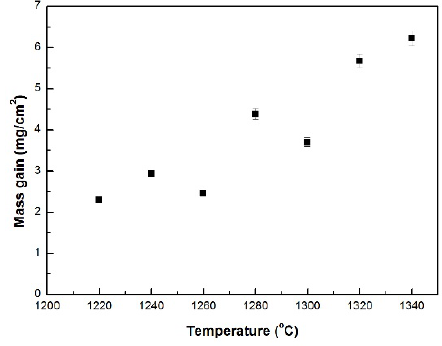
Figure 2. Mass gain at temperatures of 1220–1340 °C for 3 h.